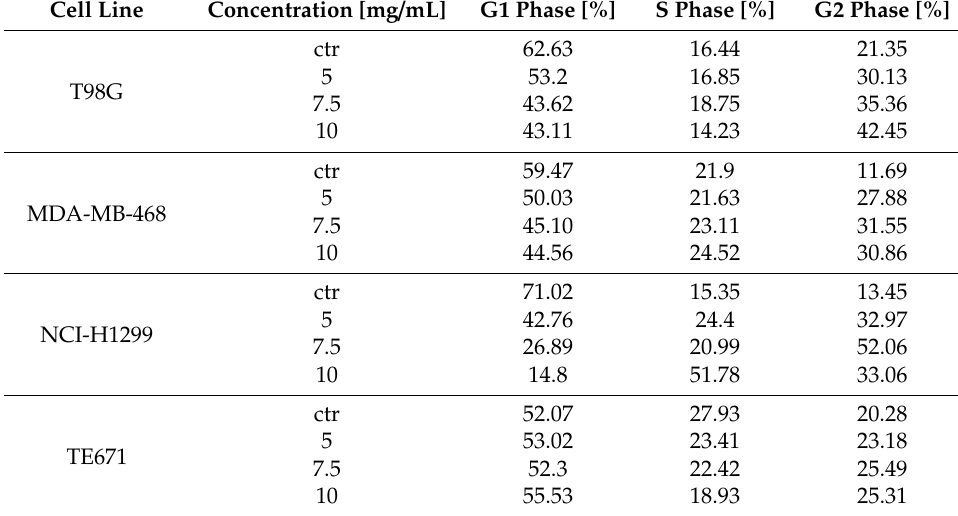
Table 4. Cell cycle analysis of T98G, MDA-MB-468, NCI-H1299, and TE671 cancer cells after treatment with MGN for 48